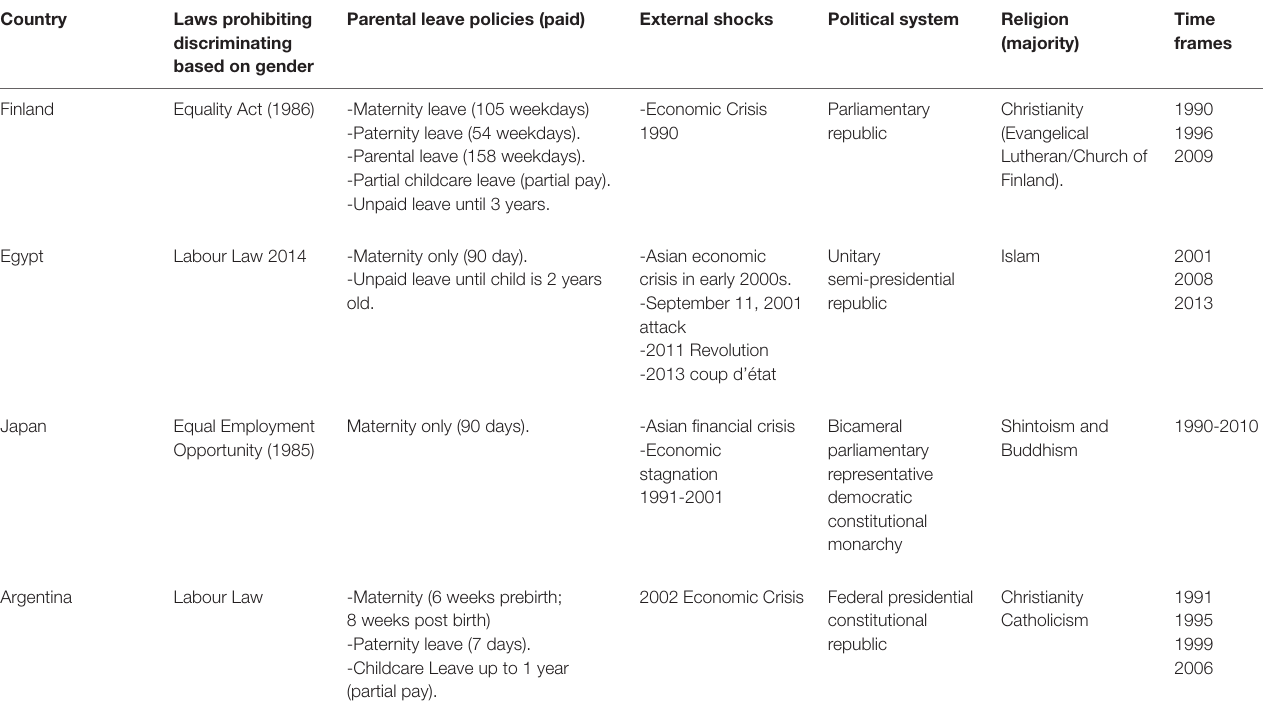
TABLE 2 | Overview of conditions and key historical events potentially affecting full-time employment, pro-equality norms, and self-reported health in four selected countries.